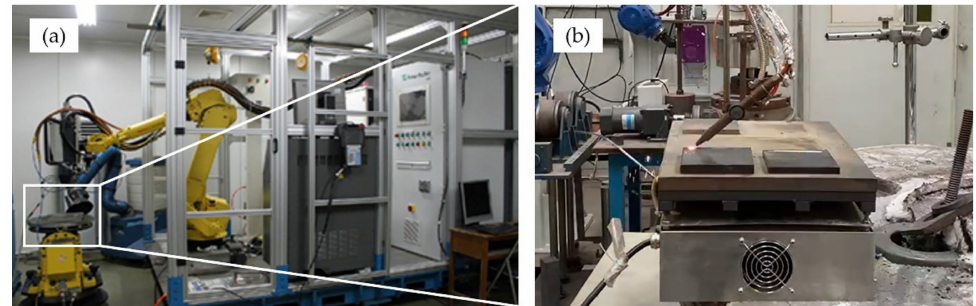
Figure 2. IPG YLS-10000 Laser Equipment: ( a ) Overview of the equipment; ( b ) Working